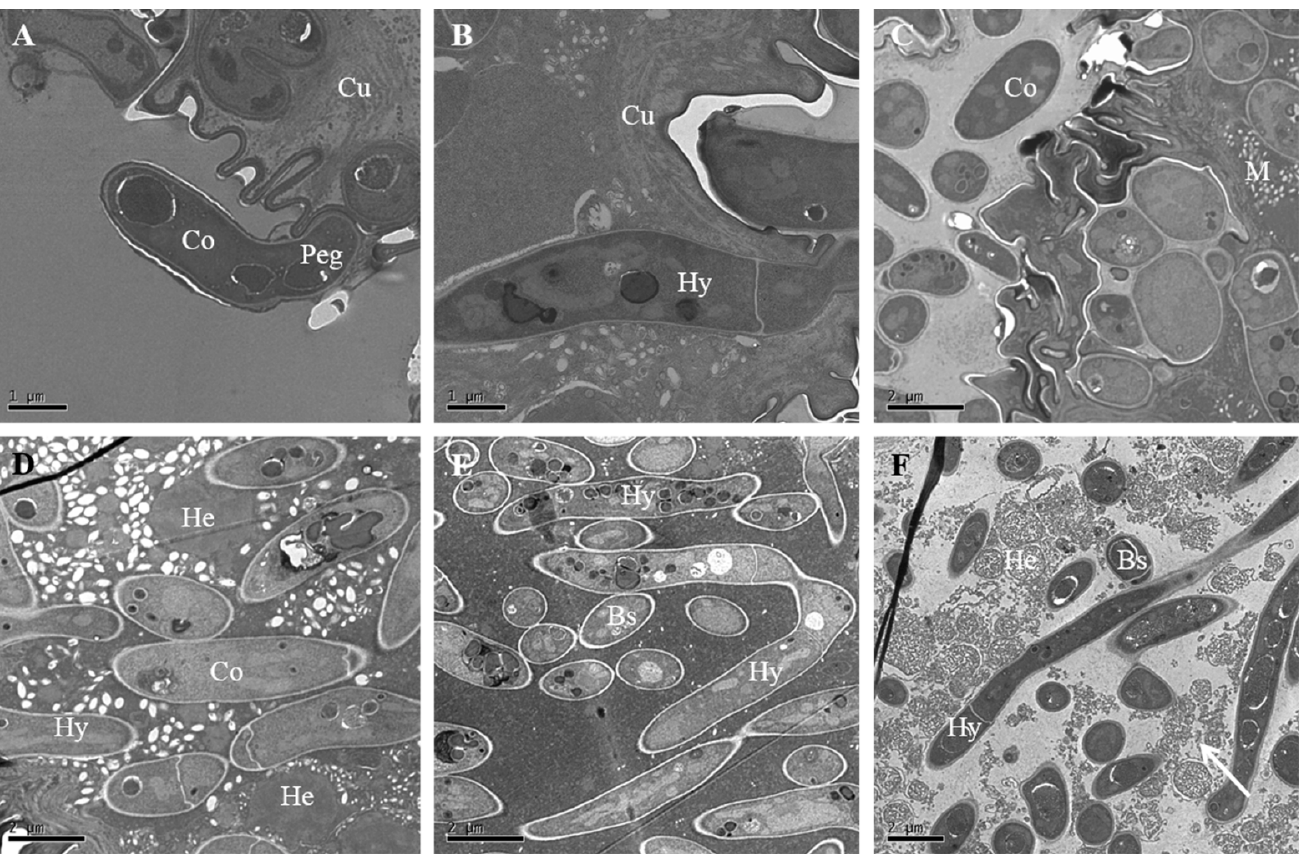
Figure 6. Stepwise invasion events of Cordyceps fumosorosea IFCF01 on the host integument visualized under transmission electron microscope. ( A , B ) were taken at 16 h after inoculation; ( A ) The tip of the conidia has differentiated into a penetration peg (Peg); ( B ) Hypha (Hy) has penetrated into the cuticular layer of the cuticle (Cu); ( C ) Hyphae have penetrated the cuticle and muscle (M) at 24 h after inoculation; ( D , E ) were taken 36 h after inoculation; ( D ) Hypha (Hy) and conidium (Co) have entered the muscle; hyphal bodies reproduced by created cell develop into blastospores (Bs). The hemocoele (He) has been colonized by blastospores; ( E ) Self-reproduction of the hyphal body (HB) was visible in the body cavity; ( F ) Hemocyte (He) damage (at arrow) was clearly visible, with disappearance of the nucleolus at 48 h after inoculation.